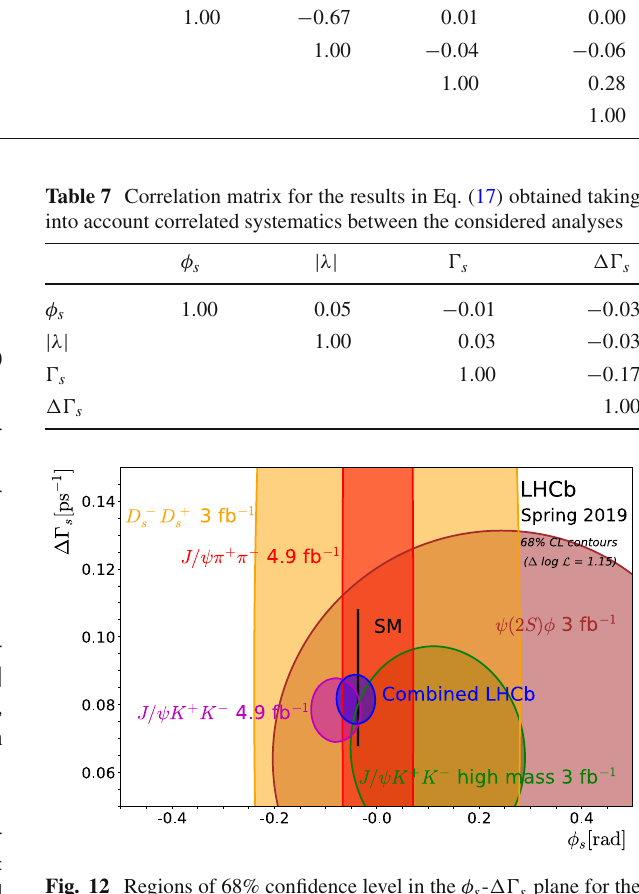
Fig. 12 Regions of 68% confidence level in the φ s - (cid:5)(cid:6) s plane for the individual LHCb measurements and a combined contour (in blue). The B 0 s → J /ψ K + K − (magenta) and B 0 s → J /ψ π + π − [67] (red) con- tours show the Run 1 and Run 2 combined numbers. The φ s [4] and (cid:5)(cid:6) s [18] predictions are indicated by the thin black rectangle The values of these parameters are the most precise